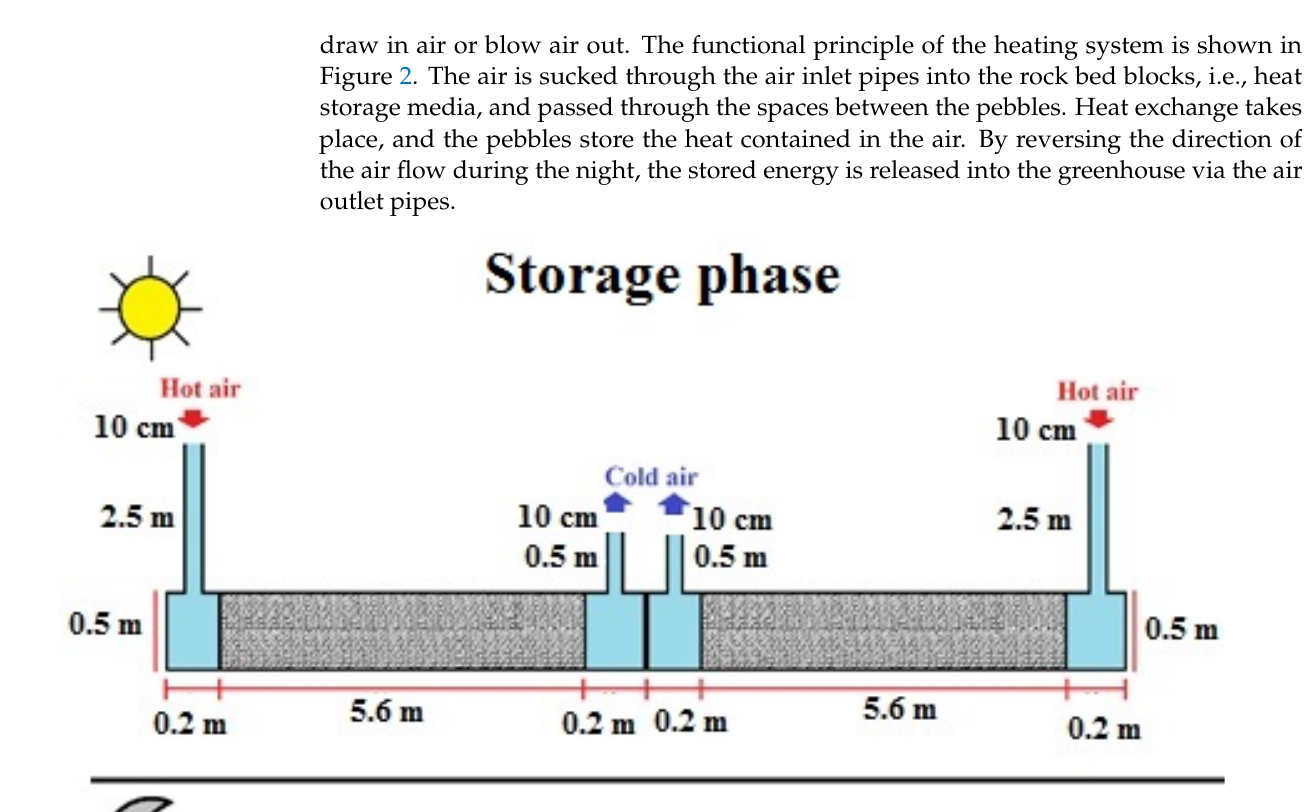
draw in air or blow air out. The functional principle of the heating system is shown in Figure 2. The air is sucked through the air inlet pipes into the rock bed blocks, i.e., heat storage media, and passed through the spaces between the pebbles. Heat exchange takes place, and the pebbles store the heat contained in the air. By reversing the direction of the air flow during the night, the stored energy is released into the greenhouse via the air outlet pipes.